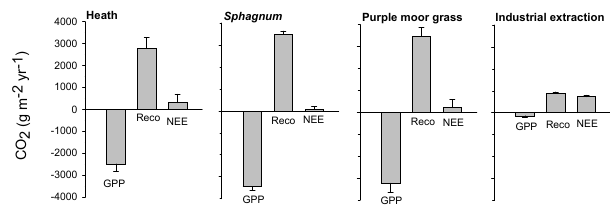
Figure 4. Annual CO 2 budgets of four different bog sites in 2011. GPP: gross primary production, Reco: ecosystem respiration and NEE: net ecosystem exchange. Values represent means of the model results of four replicates (plots) at each site ± SD. Positive values represent emissions and negative values